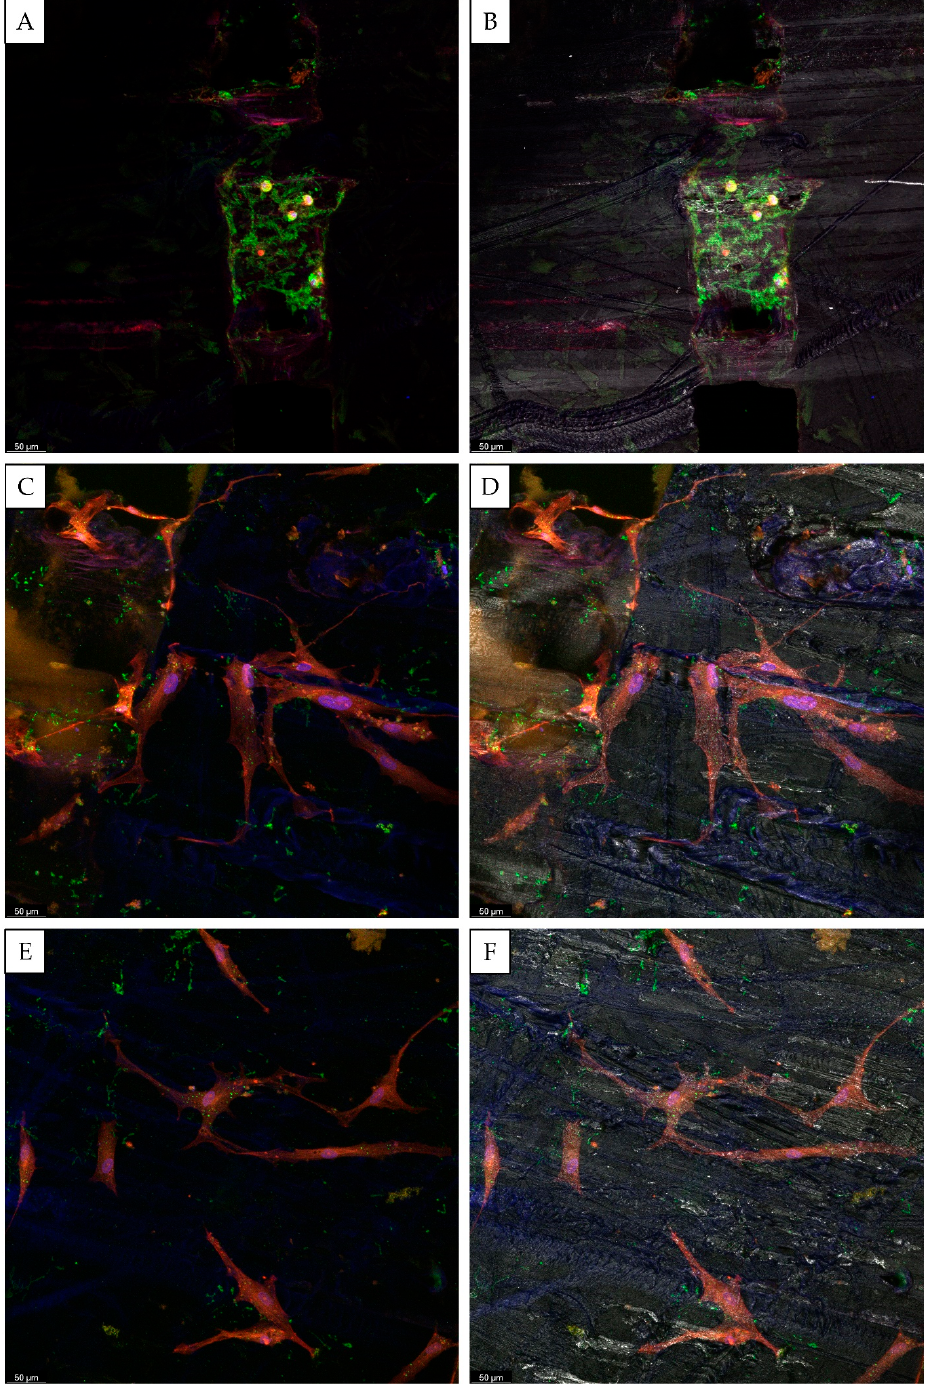
Figure 7. Confocal microscopy images of Lyosecretome scaffolds seeded with MSCs and cultured in an osteogenic medium for 28 days. Cell nuclei are stained in blue; the actin cytoskeleton is stained in red; and the mineralized matrix is stained in green ( A – F ). In ( B , D , F ), the material of the scaffold is evidenced in grey. Scale bar: 50 µ